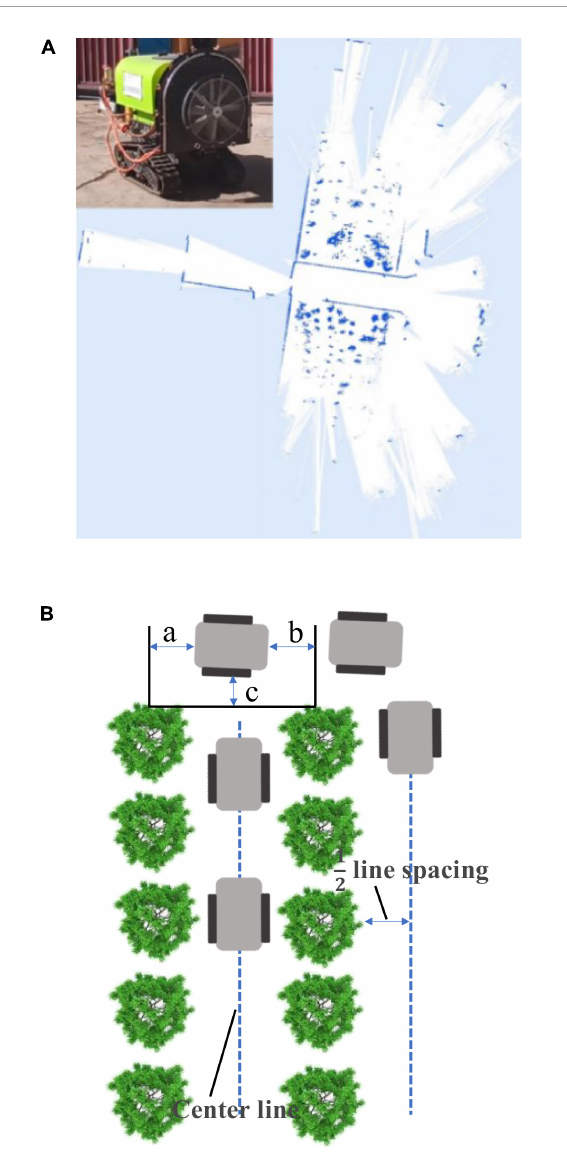
FIGURE8 Construction of local map based on RS-LiDAR-16. (A) Local map acquisition. (B) Schematic diagram of navigation